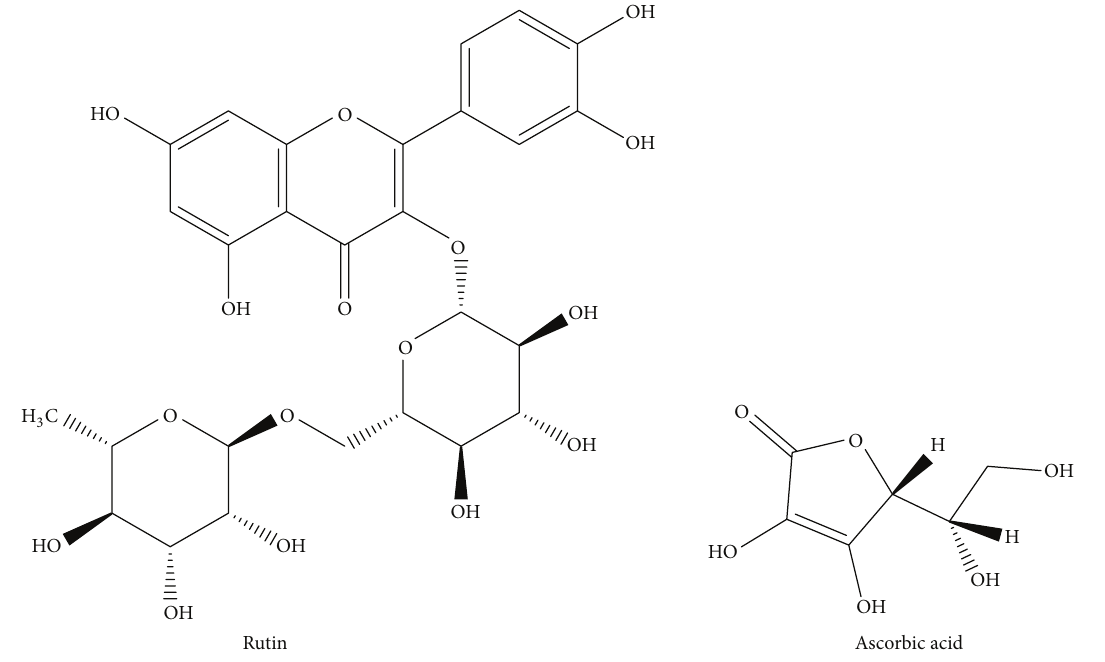
Figure 1: Chemical structures of rutin (RU) and ascorbic acid